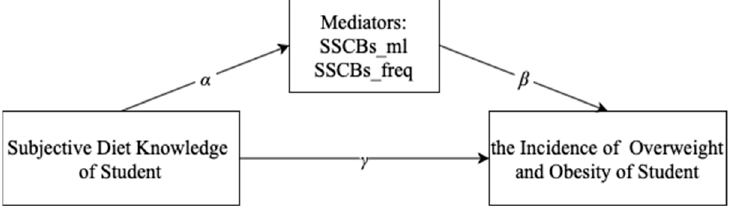
Figure 1. A hypothetical mediational model: Subjective dietary knowledge affects the incidence of overweight and obesity among students through SSCBs consumption.